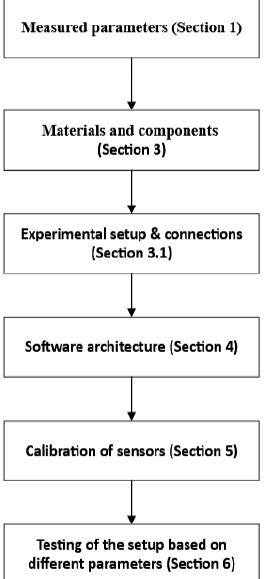
Figure 1. Research methodology.